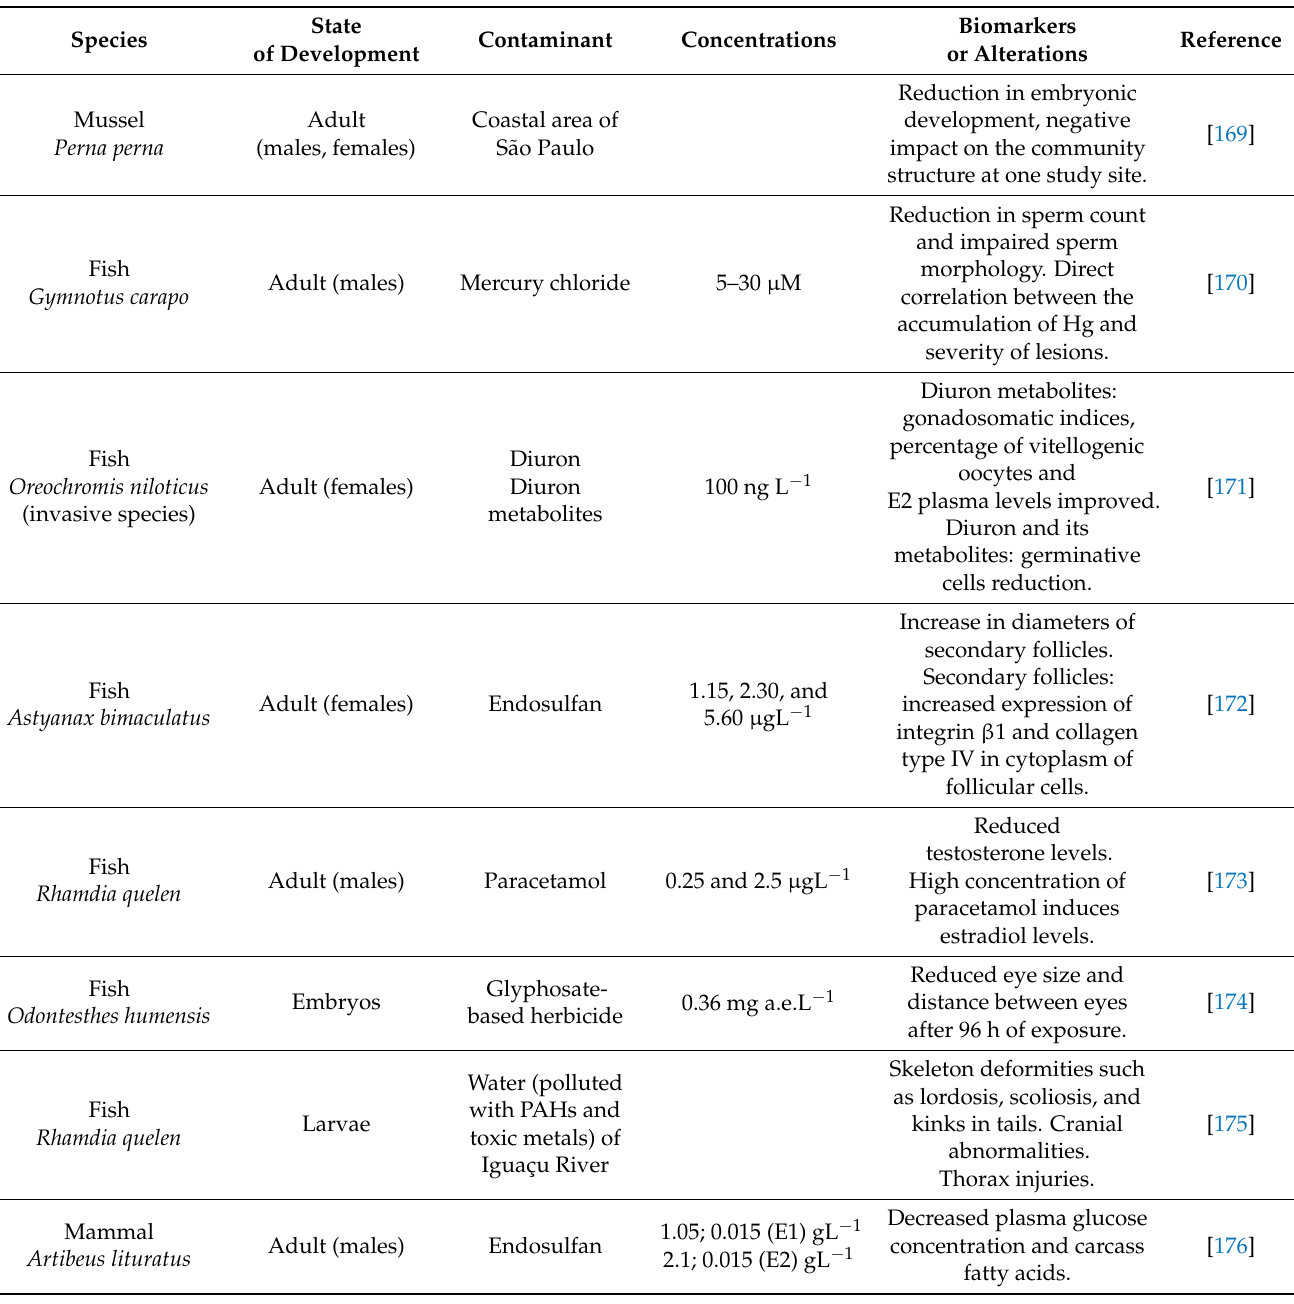
Table 3. Effects of endocrine disruptors under experimental conditions in Brazil by species, type of contaminant and biological